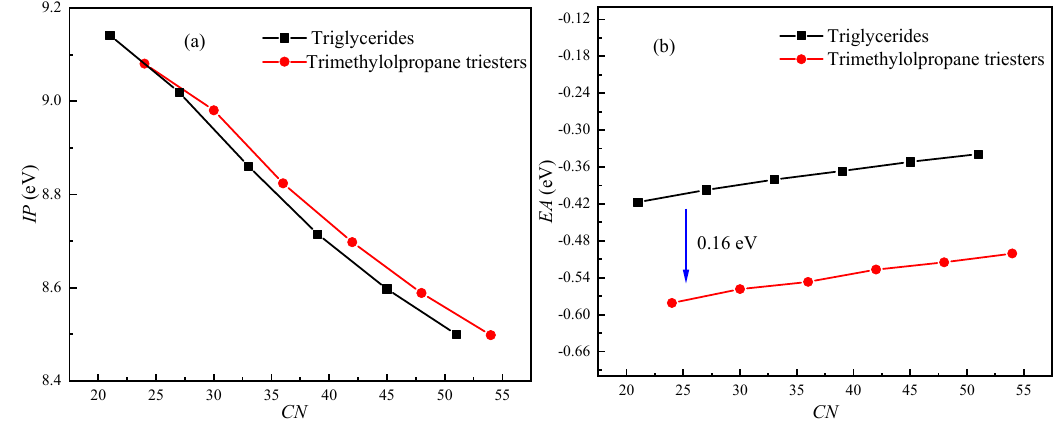
Figure 3. Effects of β -hydrogen and chain length ( CN ) on IP and EA : ( a ) IP ; ( b ) EA .